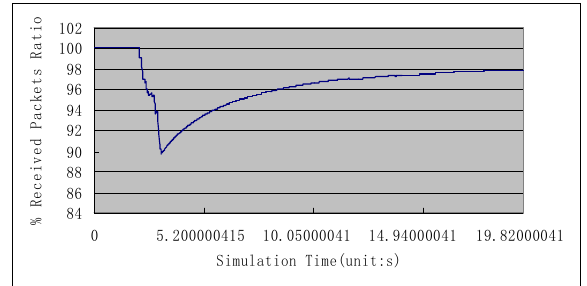
Fig.4. Results of the Received Packets Ratio Fig.5. Simulation Scenario of Detection Delay and Average